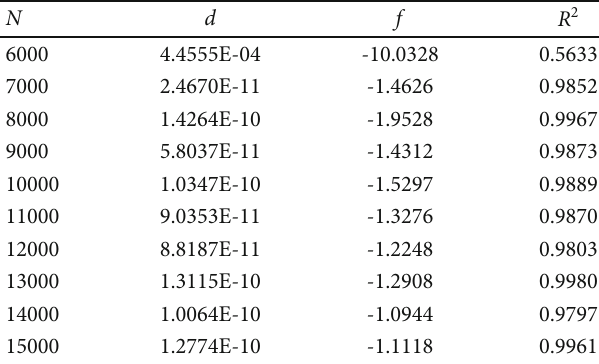
Table 4: Parameters of fi tting curves as shown in Figure